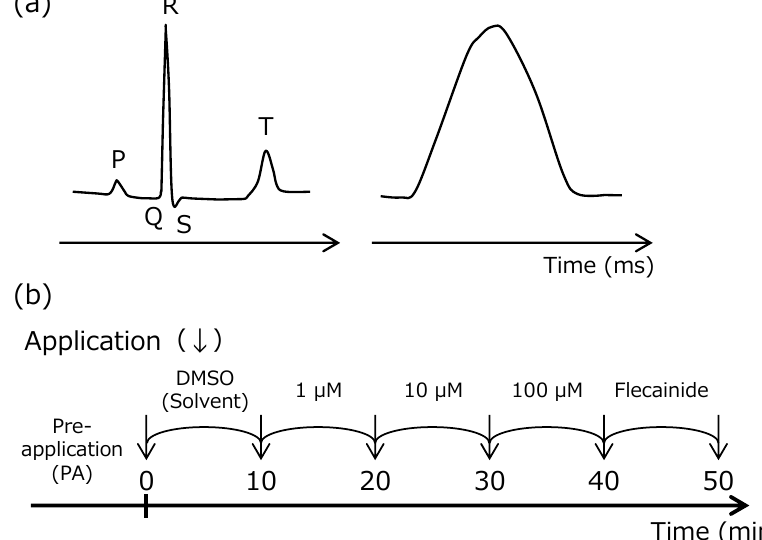
Figure 7. Parameters recorded from the Langendor ff perfused heart assay. ( a ) One wave shape of electrocardiogram (ECG) and left ventricular pressure (LVP) recording. The letters represent